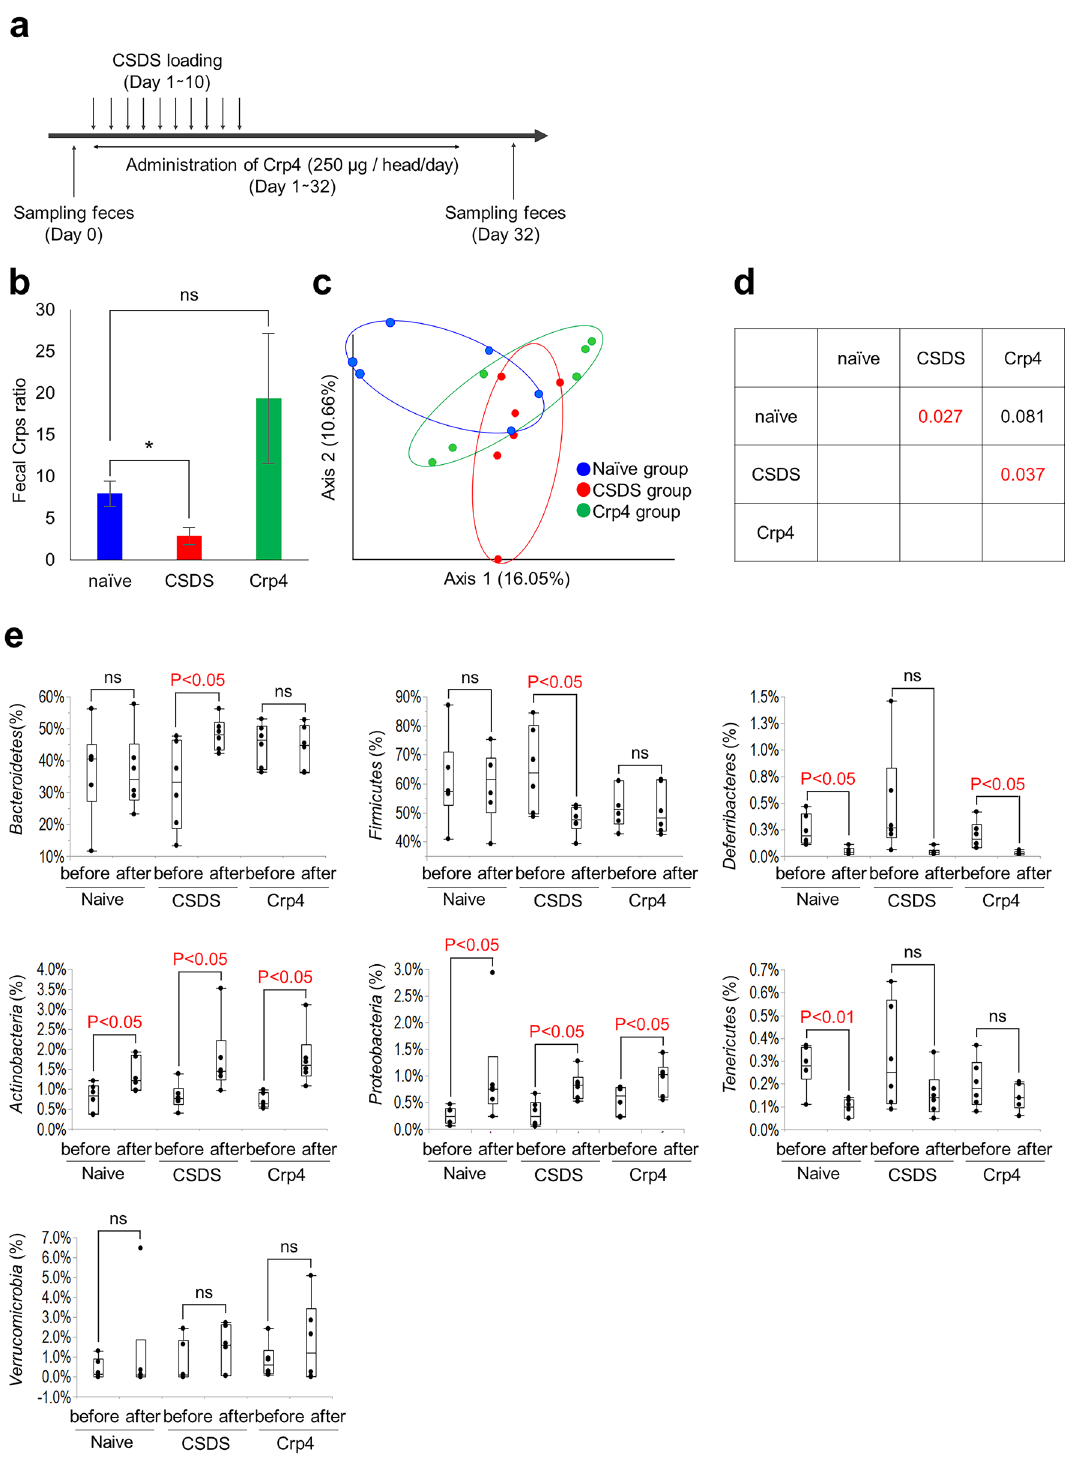
Figure 3. Change in the composition of gut microbiota in the CSDS model by α-defensin administration. ( a ) Schedule of experiment. ( b ) Fecal Crp1 + Crp4 (Crps) protein ratio in day 32 vs before CSDS. Data are shown as the mean ± SE. Steel’s test was used to compare the data (vs naïve group). * P < 0.05. ( c ) PCoA of β-diversity comparison. ( d ) The P -values of PERMANOVA test. ( e ) Changes in the genus compositions before or after CSDS (shown only > 0.1% abundance). Pairs student’s t test was used to compare the data. * P < 0.05. The data of b, c, e were shown of six independent experiments in each